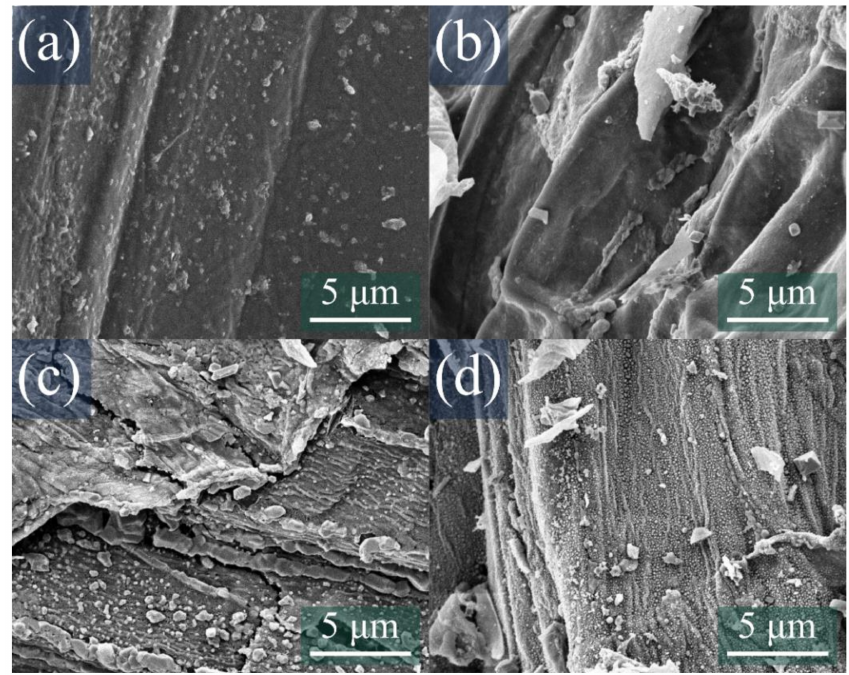
Figure 3. SEM images of as-synthesized materials; ( a ) raw material (B), ( b ) BA-0.01, ( c ) BA-0.03, and ( d ) BA-0.05